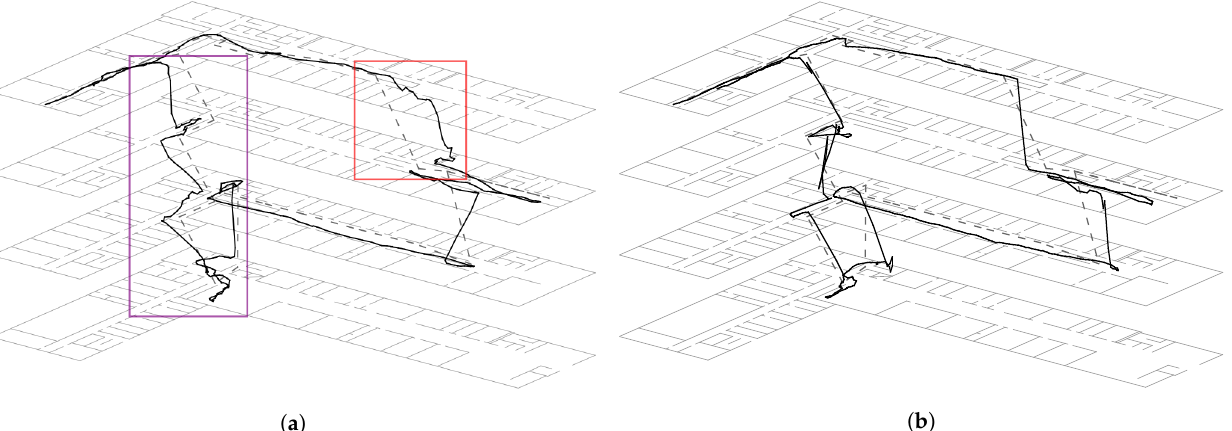
Figure 3. A typical localization results for the second path using ( a ) all sensors except the barometer model and ( b ) including it. The path is 120m long and it takes 3min to walk